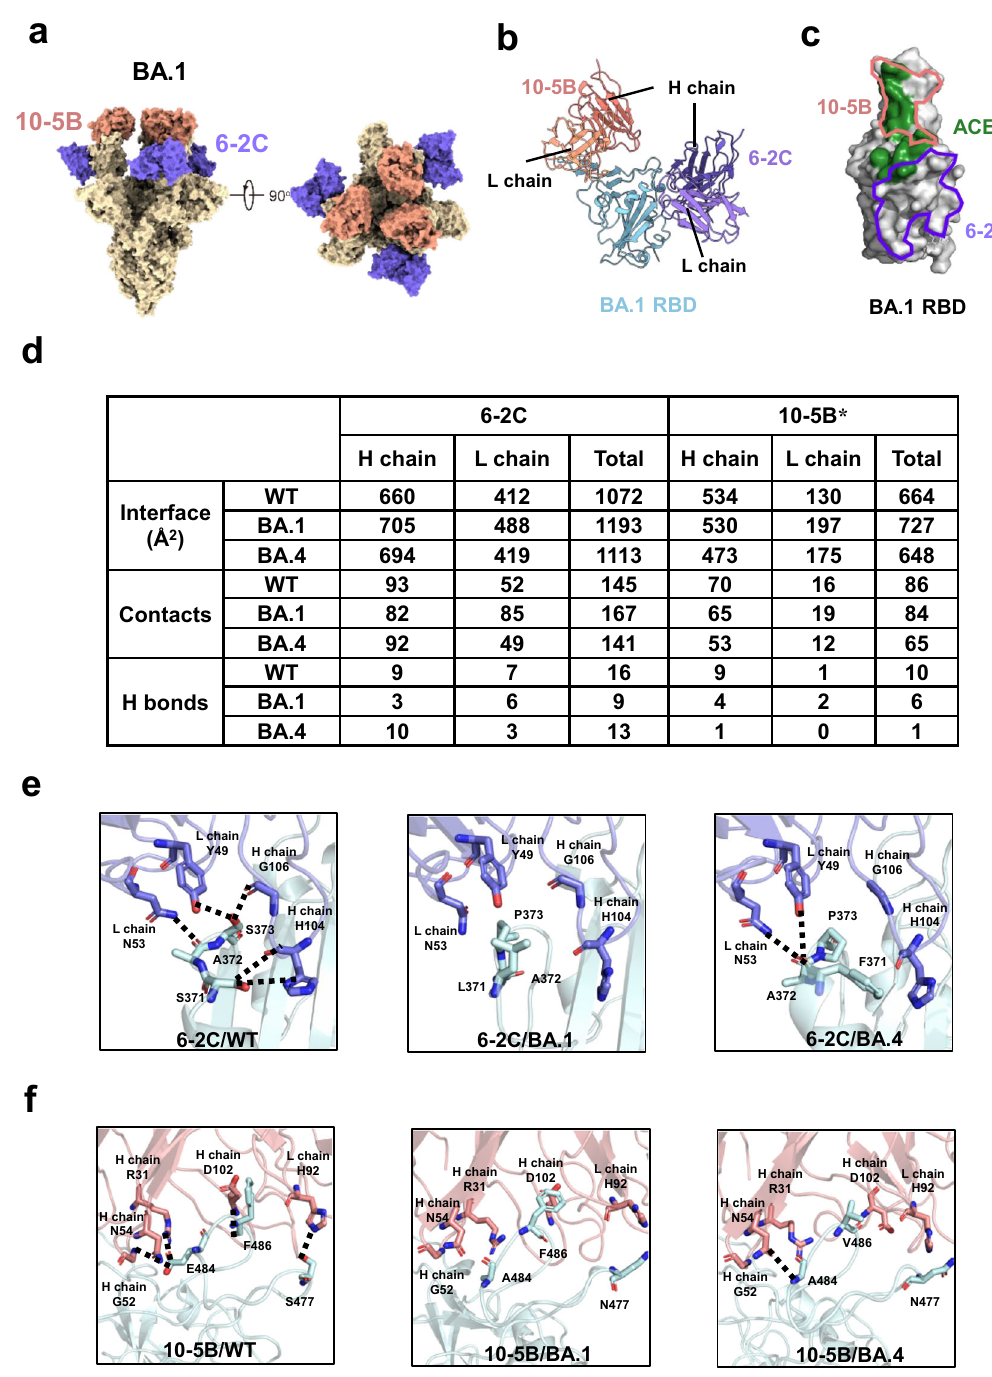
Fig. 5 | Structural characterization of the mAbs 6-2C and 10-5B. a Cryo-EM structure viewed along two orthogonal orientations of the SARS-CoV-2 Omicron BA.1 S trimer (yellow) bound with 10-5B Fab (salmon) and 6-2C Fab (purple). The three “ up ” RBDs are bound by three 10-5B Fabs and three 6-2C Fabs, respectively. b Cartoondiagramofone10-5BFab(heavychainindeepsalmonandlightchainin salmon) and one 6-2C Fab (heavy chain in deep purple and light chain in light purple) bound to one SARS-CoV-2 RBD (cyan). c The superposition of 10-5B